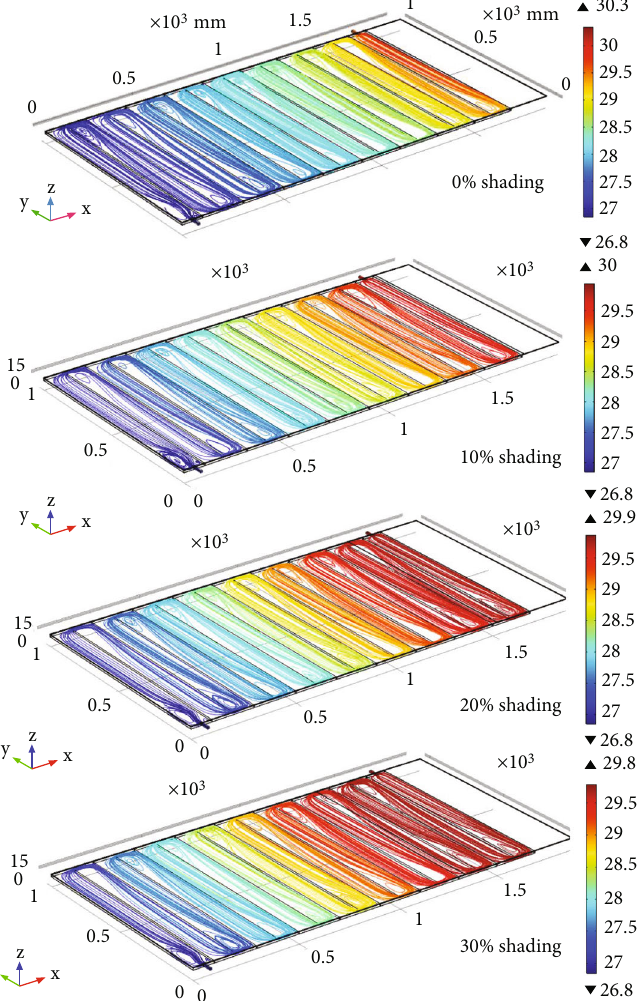
Figure 11: Outcome of partial shading on PVT streamlines plot with G = 500W/m 2 , V